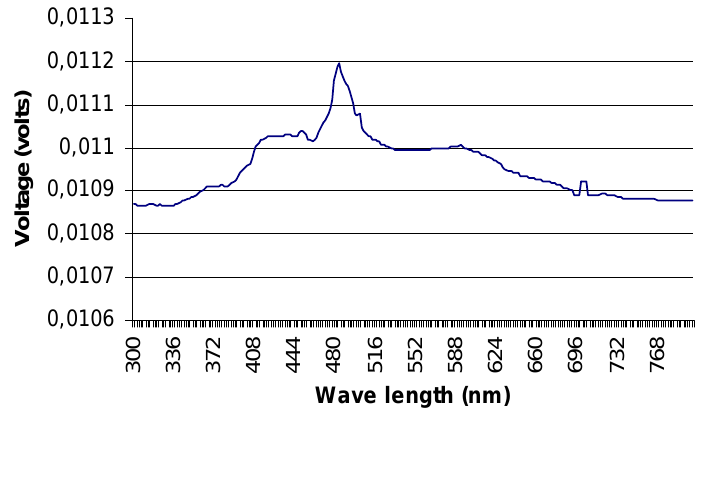
Figure 12. Spectral response curve obtained for the RTP pyranometer in the INTA calibration